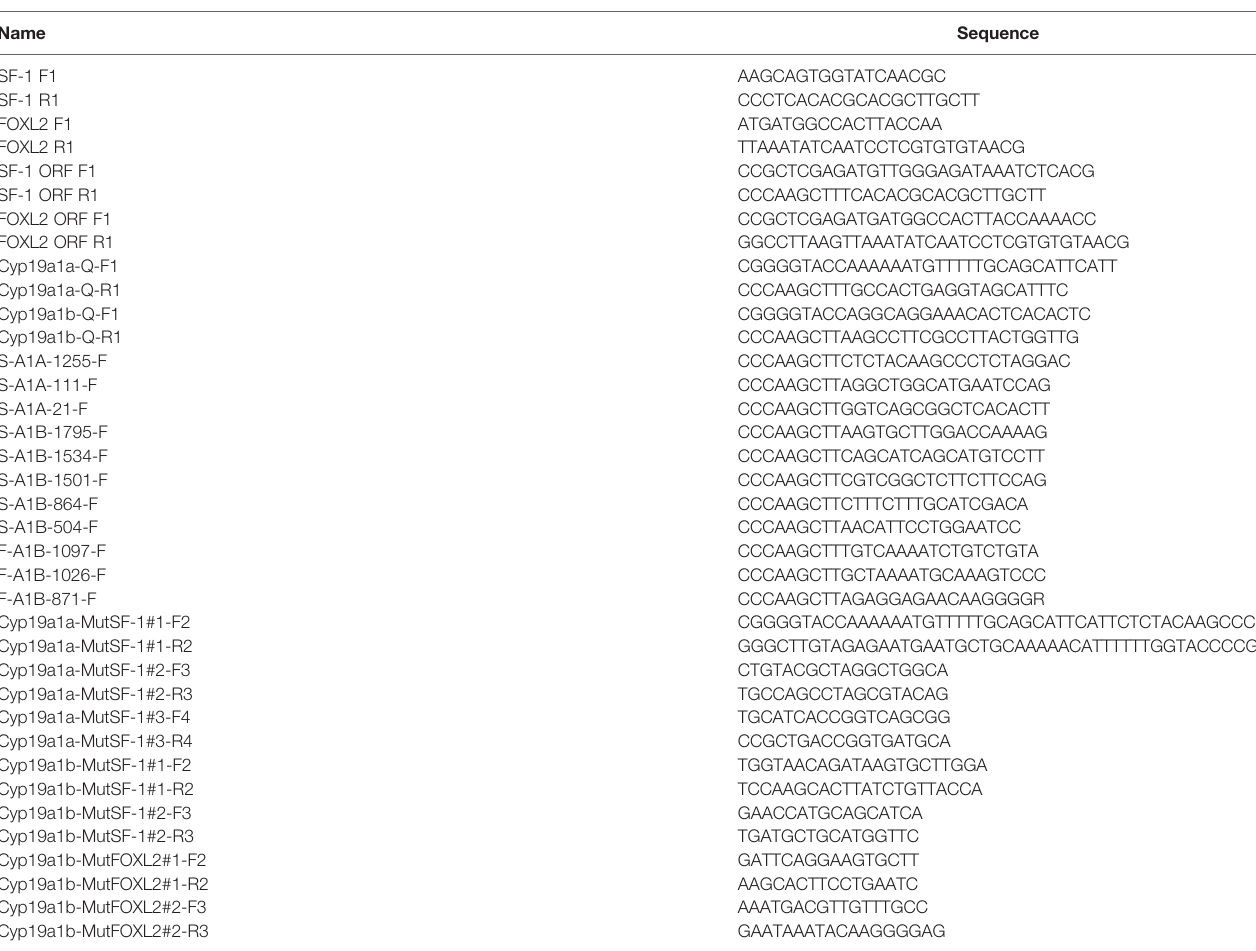
TABLE 1 | Primers used in genes cloning and vector